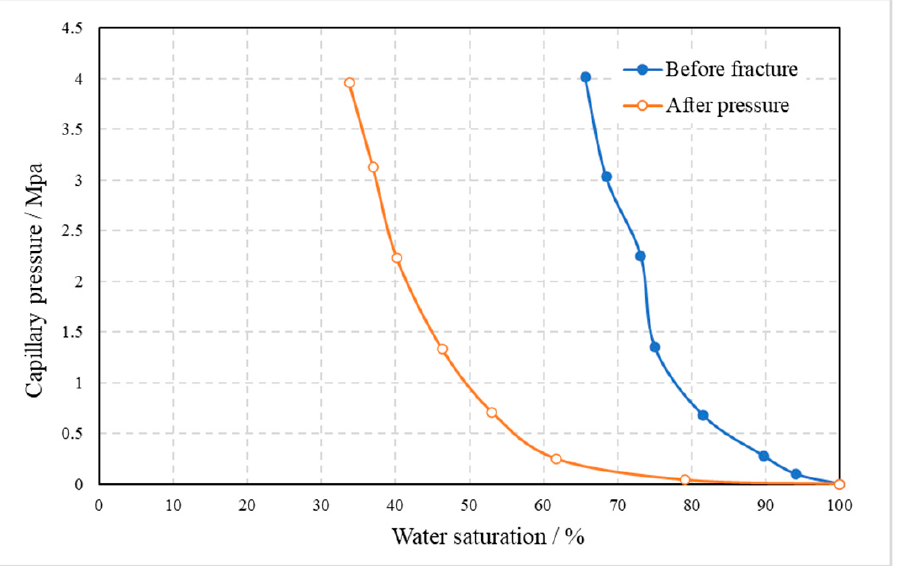
Figure 2. Variation of displacement pressure.